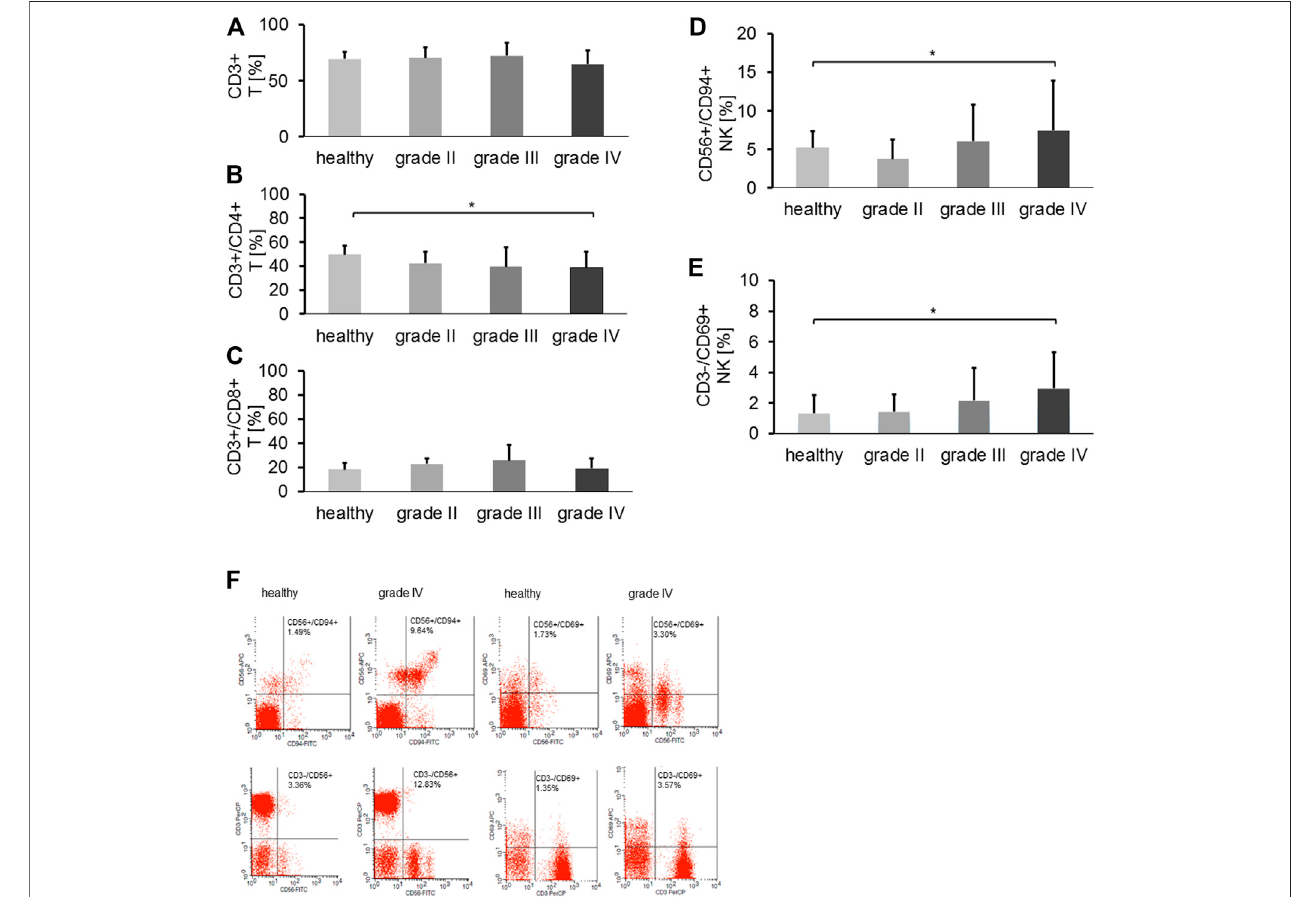
FIGURE 4 | (A) The proportion of CD3 + T cells in healthy controls ( n (cid:1) 15) vs. grade II ( n (cid:1) 6), grade III ( n (cid:1) 13) and grade IV gliomas ( n (cid:1) 56) in the peripheral blood. (B) The proportion of CD3+/CD4+ T helper cells in healthy controls ( n (cid:1) 15) vs. grade II ( n (cid:1) 6), grade III ( n (cid:1) 13) and grade IV gliomas ( n (cid:1) 56) in the peripheral blood (Tukey; * p < 0.05). (C) The proportion ofCD3+/CD8+ cytotoxic Tcells in healthy controls ( n (cid:1) 15) vs. grade II( n (cid:1) 6), grade III ( n (cid:1) 13)and grade IV gliomas ( n (cid:1) 56)in the peripheral blood. (D) The proportion of CD3-/CD94+ NK cells in healthy controls ( n (cid:1) 15) vs. grade II ( n (cid:1) 6), grade III ( n (cid:1) 13) and grade IV gliomas ( n (cid:1) 56) in the peripheralblood(* p < 0.05). (E) TheproportionofCD3-/CD69+NKcellsinhealthycontrols( n (cid:1) 15)vs.gradeII( n (cid:1) 5),gradeIII( n (cid:1) 13)andgradeIVgliomas( n (cid:1) 56)inthe peripheralblood(* p < 0.05). (F) RepresentativedotblotanalysisoftheproportionofCD56+/CD94+(1.49%vs.9.64%),CD3-/CD56+(3.36vs.12.83%),CD56+/CD69+ (1.73 vs. 3.30%) and CD3-/CD69+ (1.35% vs. 3.57%) NK cells in a healthy control vs. a grade IV glioma patient,